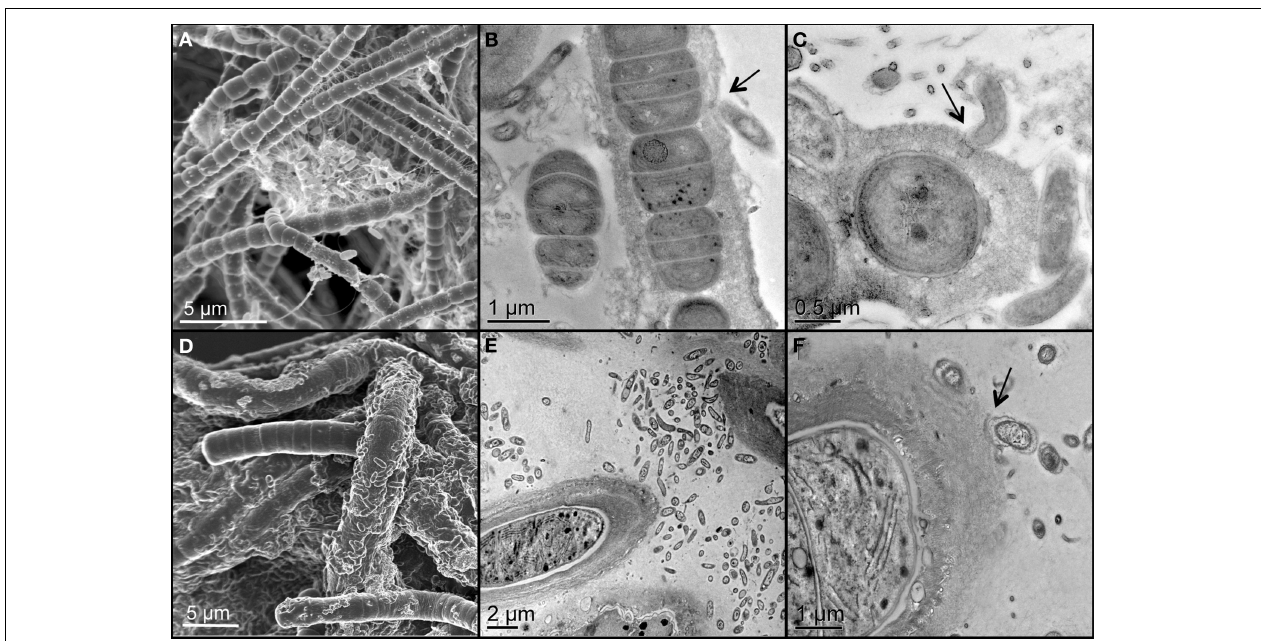
FIGURE 2 | Scanning and transmission electron micrographs of the consortia, UCC-A (A–C) and UCC-O (D–F). Filamentous cyanobacteria can be seen encased in low-electron-density exopolymeric substance (EPS) in